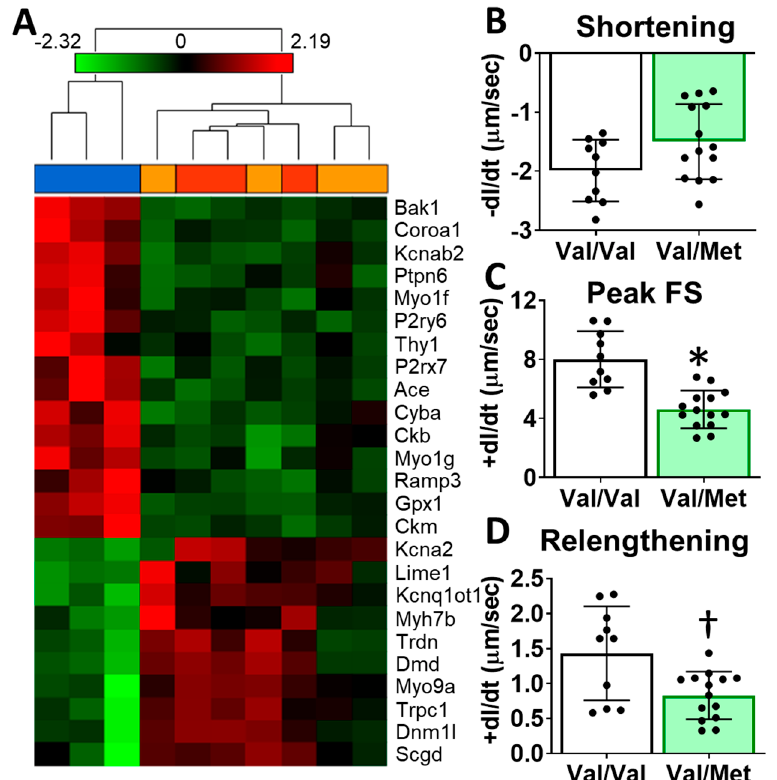
Figure 4. Val66Met mice have altered cardiac tissue gene expression of contractile proteins and reduced cardiomyocyte contractility. ( A ) Hierarchical cluster of cardiac-associated genes identified as significantly differential (FDR-corrected p < 0.01, fold-difference > 1.5) using deep sequencing. Vertical dendrograms and columns represent individual samples from whole hearts of Val/Val (blue), Val/Met (orange), and Met/Met (red) mice. Rows represent individual transcripts, indicated by official gene symbol. Heat map colors represent the highest (bright red), lowest (bright green) and median (black) expression levels. ( B – D ), Contractility measurements of isolated cardiomyocytes from Val/Val (V, white bars, n = 10) and Val/Met (VM, green bars, n = 14) mice showing the change in length (dl) over time (dt). Comparisons by two-way ANOVA. Asterisk represents statistical significance for V versus VM * p < 0.0001, † p = 0.0084.